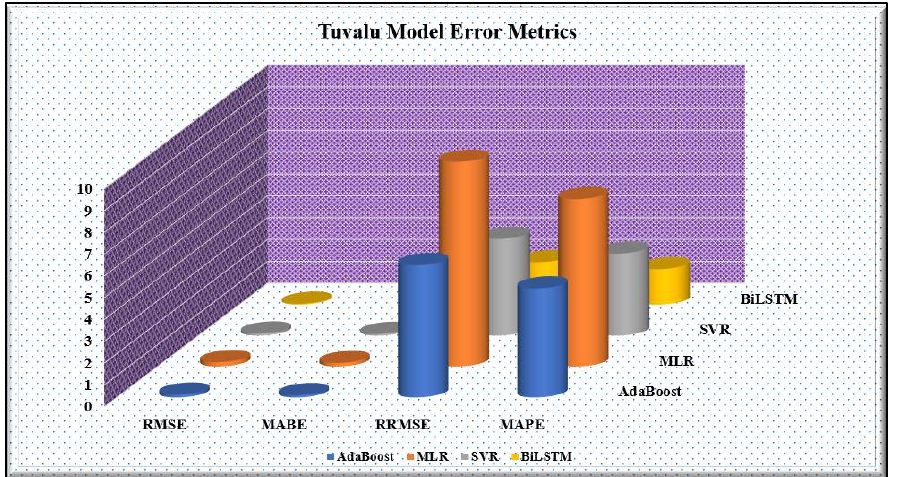
Figure 16. Bar chart of error metrics for Tuvalu.